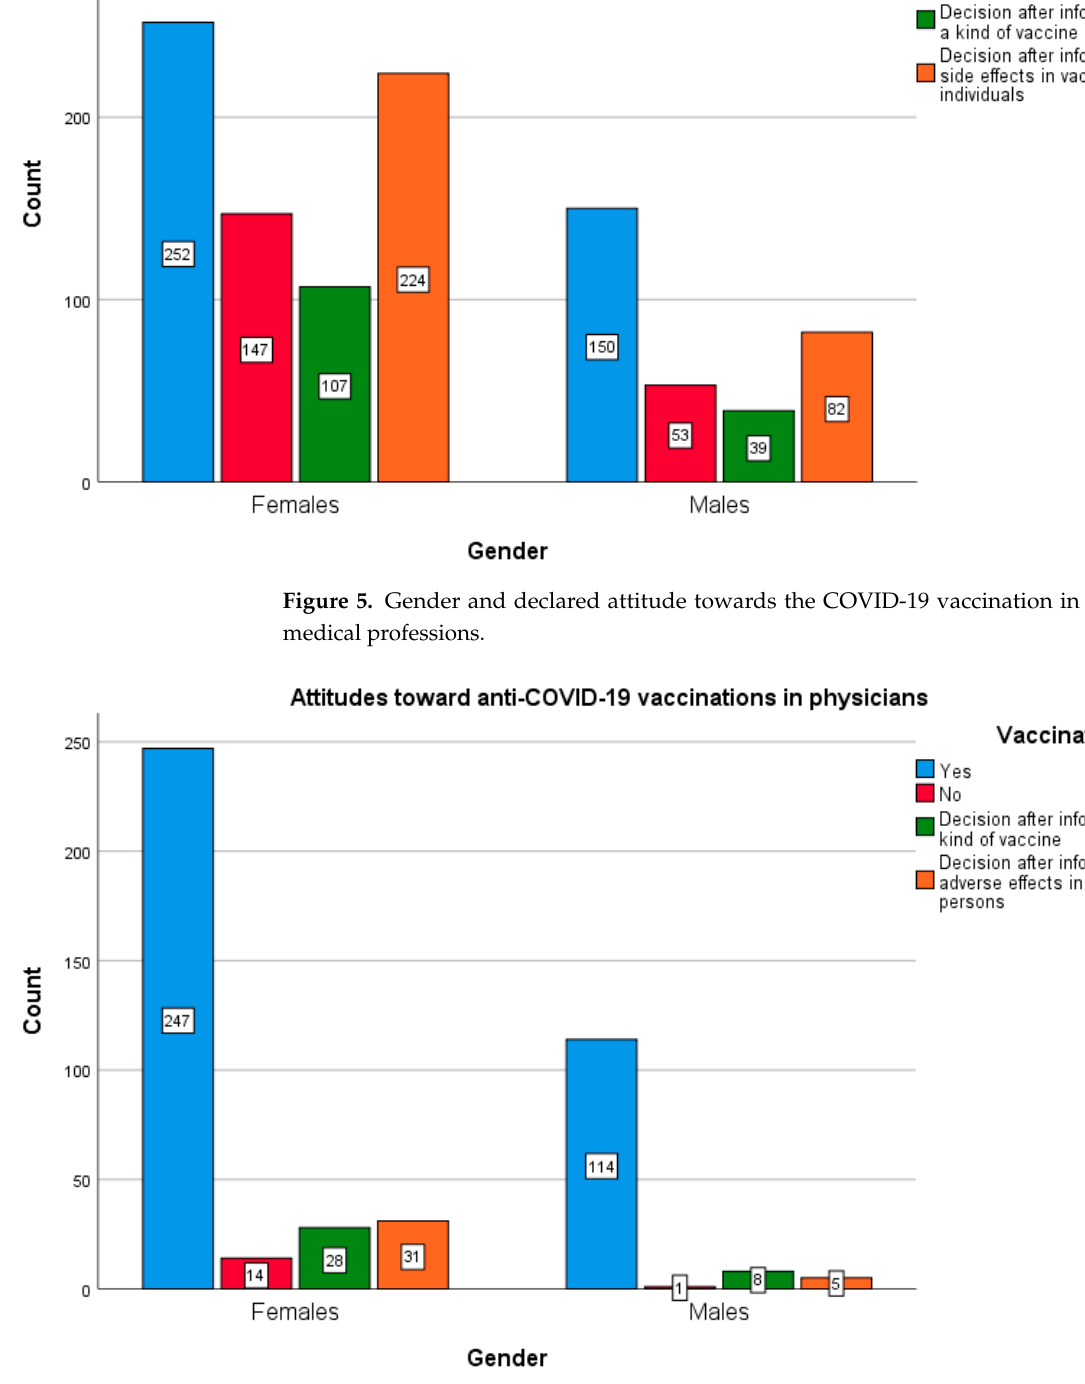
Figure 6. Gender and declared attitude towards COVID-19 vaccination in the group of